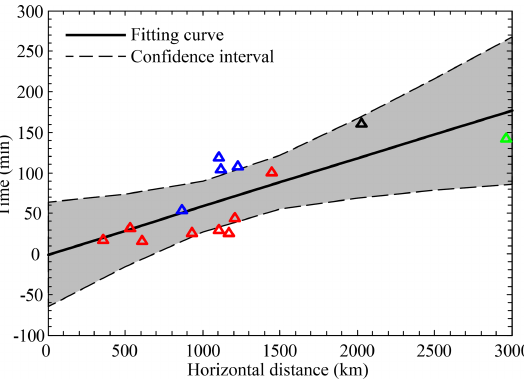
Figure 7. Horizontal distance–time data for the UNE-generated ionospheric disturbances. The black line indicates the fitting curve obtained by the least square method. The gray lines represent the boundaries of 95% confidence intervals. The red and blue triangles have the same meaning as in Fig. 5. The black triangle represents the position of ionospheric current disturbances in the Northern Hemi- sphere. The green triangle represents the geomagnetic conjugate position of ionospheric current disturbances in the Southern Hemi-